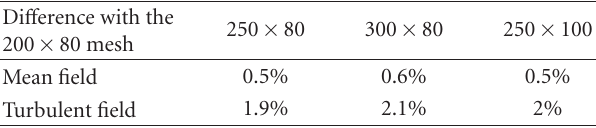
Table 1: Influence of the mesh grid on the mean and turbulent fields for G = 0 . 02, Re = 10 6 , and C w = 0. Comparisons with the 200 × 80 mesh which is chosen as the reference mesh grid. Di ff erence with the 250 × 80 300 × 80 250 × 100 200 × 80 mesh Mean field 0.5% 0.6% 0.5% Turbulent field 1.9% 2.1%